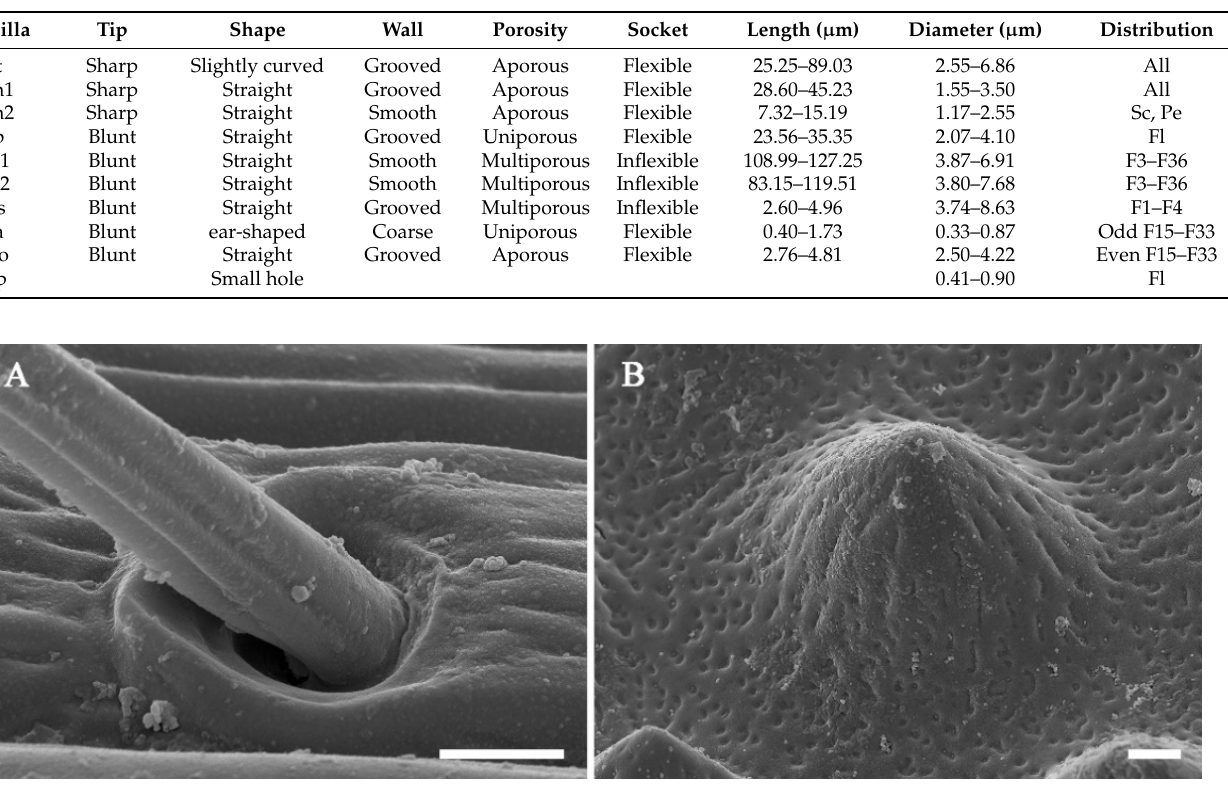
Table 2. Morphological characteristics and distribution of the antennal sensilla of female and male Coeloides qinlingensis .